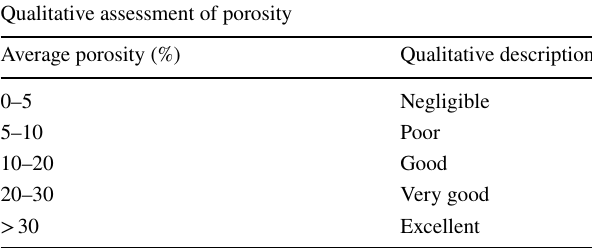
Table 2 Qualitative assessment of porosity for a reservoir (Rider 1996)